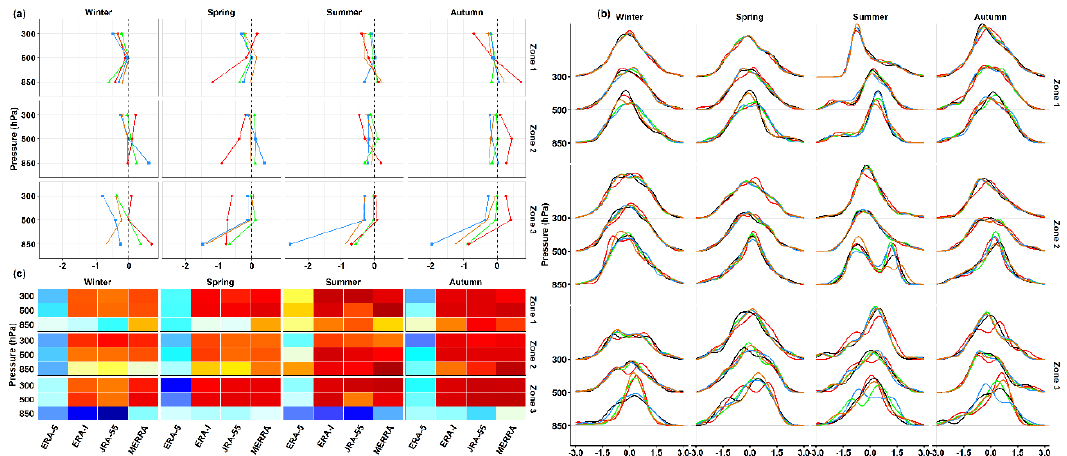
Figure 9. As in Figure 7, but for v-wind (m/s).